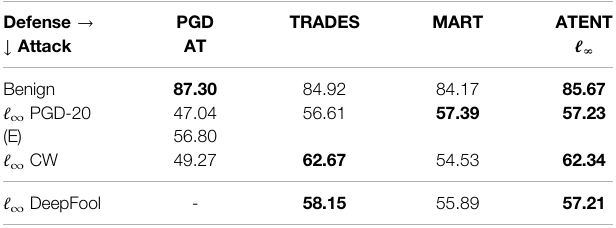
The highest two accuracy values in each row are